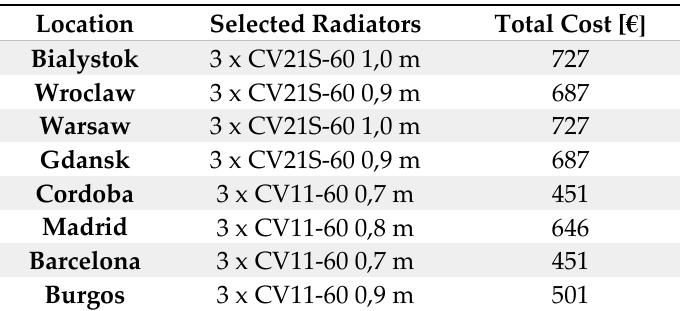
Table 2. Selection of radiators.